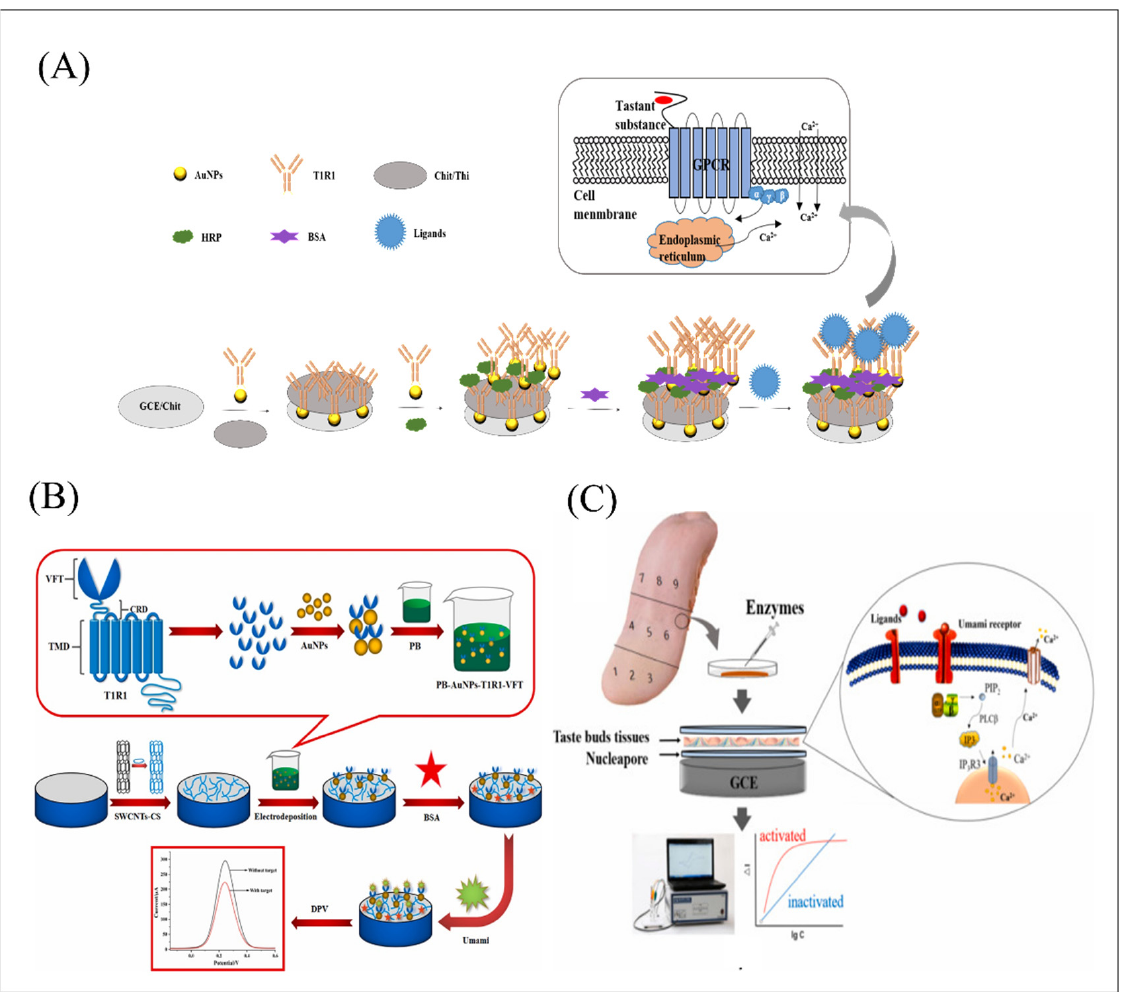
Figure 7. Schematic of biomimetic olfactory and gustatory biosensors based on electrochemical biosensor functionalized with different types of sensitive materials and data analysis. ( A ) Schematic of the double-layer gold nanoparticle (AuNPs) biosensor for simulating the linkage of the signal during the generation and amplification process from the extracellular to the intracellular sites on umami discrimination (right insert). Reproduced with permission from Ref. [66]. ( B ) Schematic of the preparation process of the T1R1-VFT electrochemical biosensor for umami detection. Reproduced with permission from Ref. [112]. ( C ). Schematic of the deigned gustatory biosensors based on sandwich-type structure consisting of aldehyde starch gel solution and sodium alginate solution in proportion and the different position of taste bud tissue as a core for umami detection. Reproduced with permission from Ref. [65].